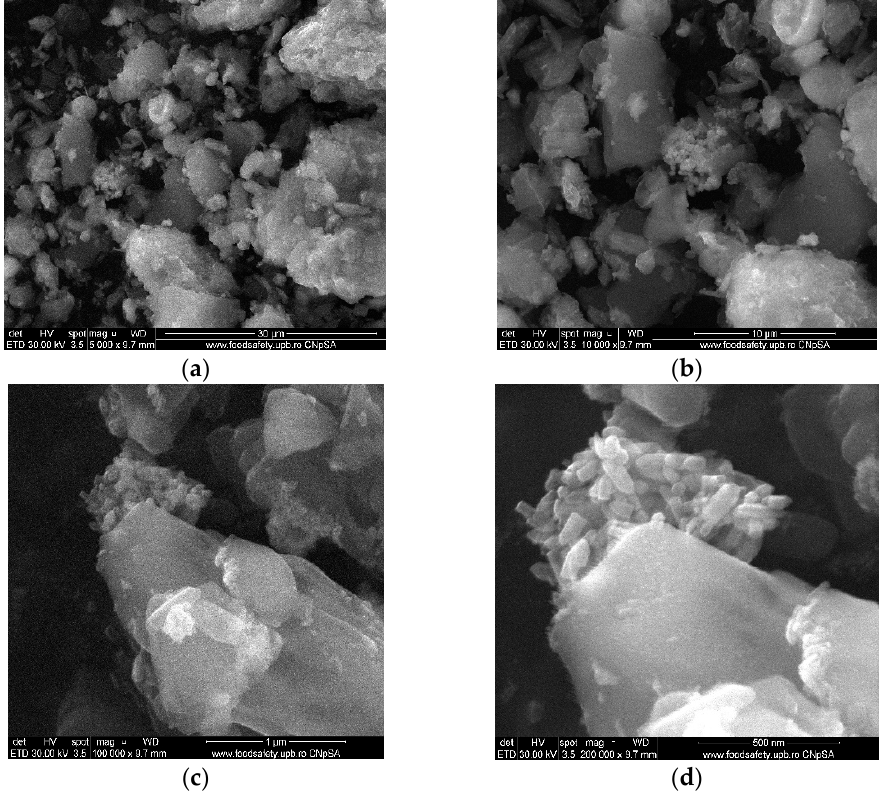
Figure 5. SEM images for ZnO powder, ( a ) 5000× magnification, ( b ) 10,000× magnification, ( c ) 100,000× magnification, ( d ) 200,000× magnification.